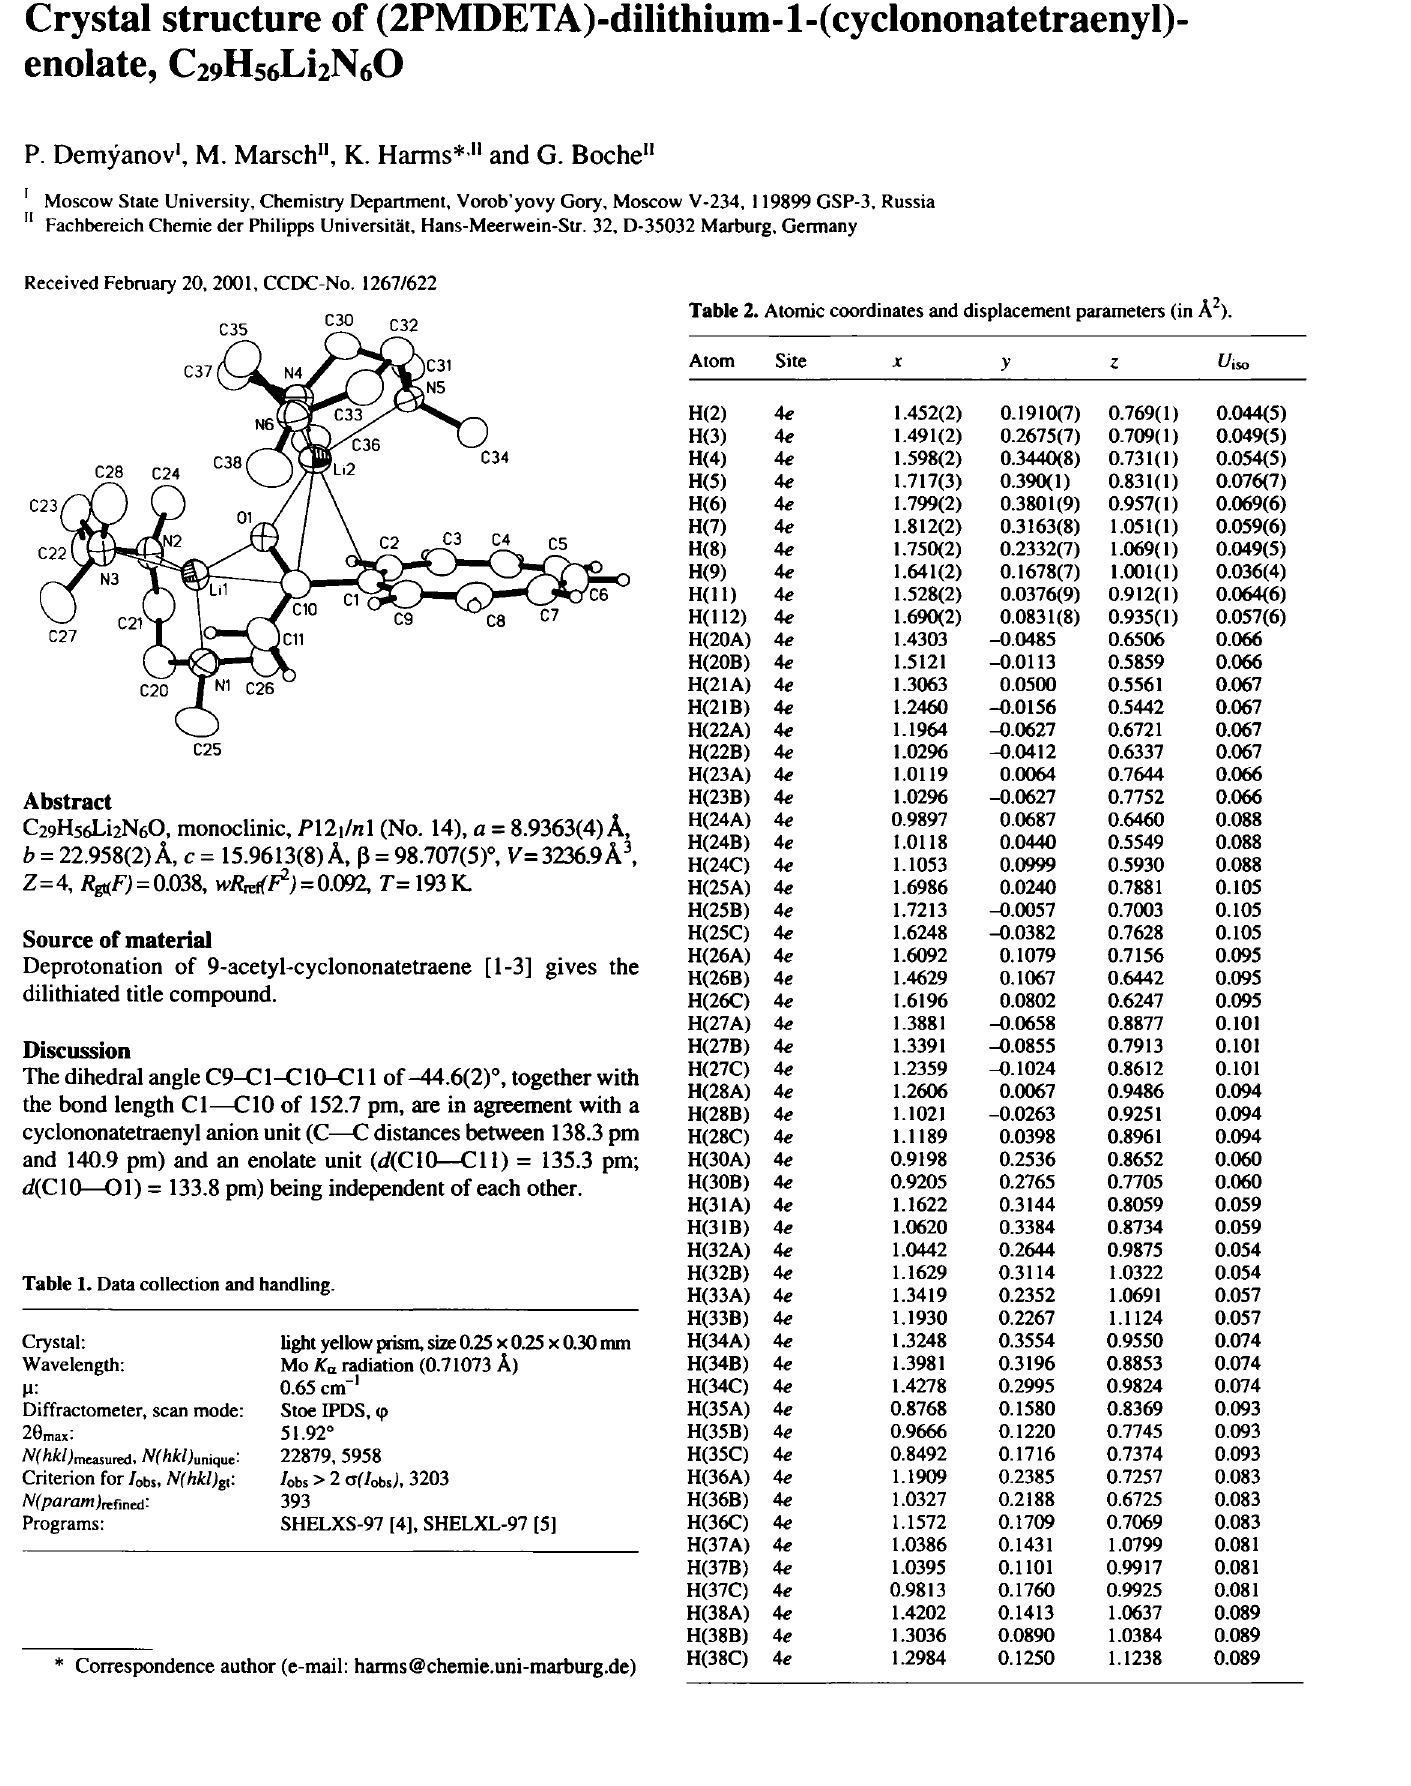
Table 2. Atomic coordinates and displacement parameters (in A 2 ).